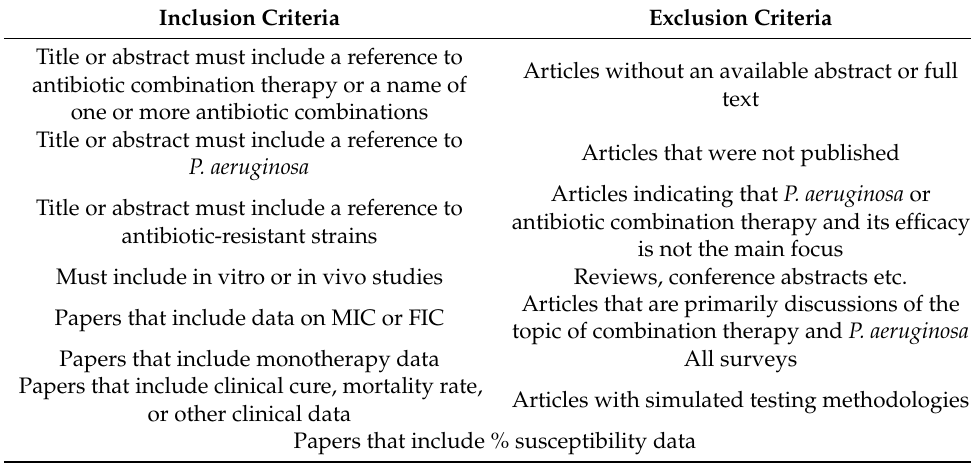
Table 8. Inclusion and exclusion criteria for the literature